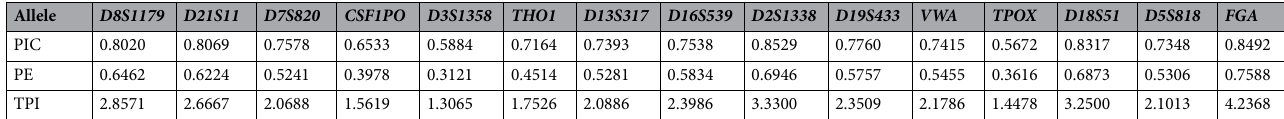
Table 2. Allele frequencies of total southern Thais based on the 15 autosomal STR loci ( n = 334). No. alleles, number of allele; H O , observed heterozygosity; H E , expected heterozygosity; HWE, Hardy–Weinberg p value; MP, matching probability; PD, power of discrimination; PIC, po ly mo r p h ic i nformation content; power of discrimination; TPI, total paternity index; GD, gene diversity; CMP, combined matching probability; CPD, combine power d isc rim in ation; CPE, combined pow er